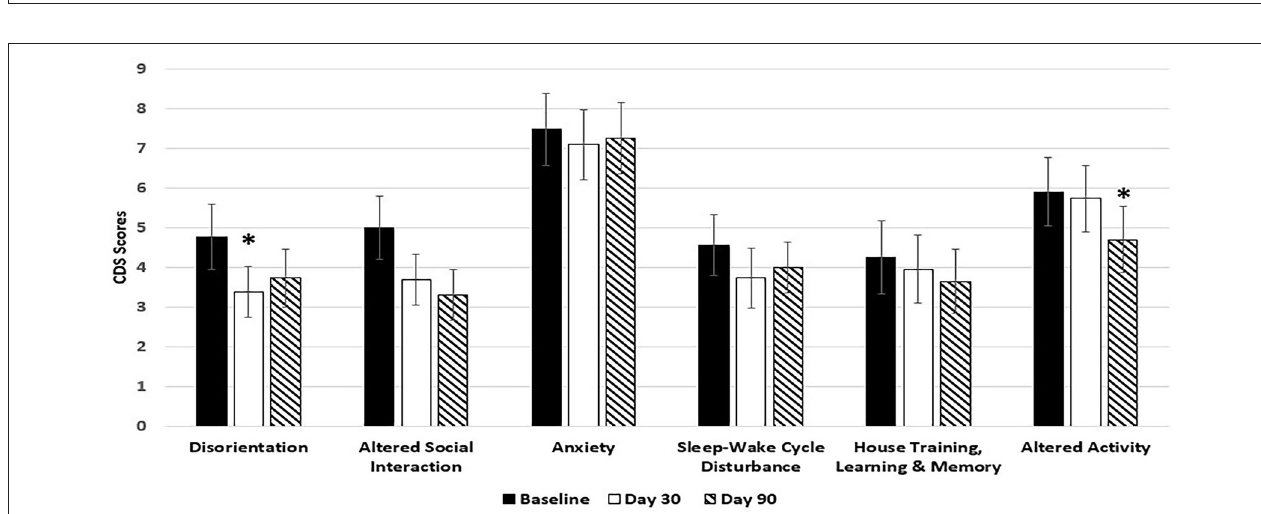
FIGURE 2 | Effects of 9% MCT diet on CDS signs at day 30 and day 90. Twenty-nine client owned dogs were assessed for six different behavioral signs of cognitive dysfunction syndrome (CDS) and then placed on the 9% MCT diet. The dogs were re-assessed after 30 days and again after 90 days. The bars illustrate Means ± SEM for each of the measures at baseline, 30 days and 90 days. Fisher Exact Probability test for multiple comparisons was used to compare baseline with day 30 and day 90. The asterisks indicate statistically significant differences ( p < 0.05) from baseline. Six dogs dropped out of the